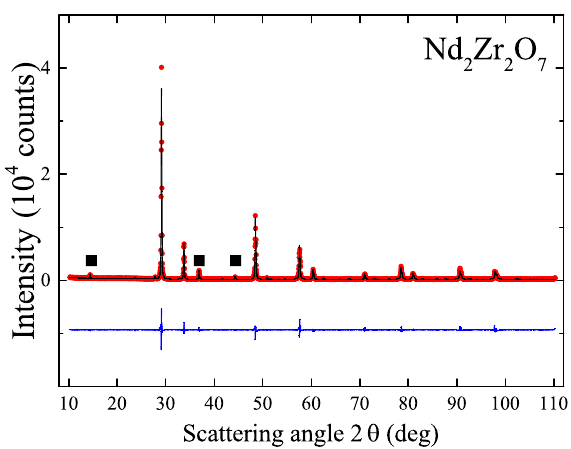
Figure 10. Powder X-ray diffraction pattern collected on a ground boule of Nd 2 Zr 2 O 7 prepared in air at a rate of 12.5 mm/h. The experimental profile (red closed circles) and a full profile matching refinement (black solid line) to the pyrochlore structure are shown, with the difference given by the blue solid line. ” (cid:110) ” indicate the low angle superlattice reflections of the pyrochlore structure.